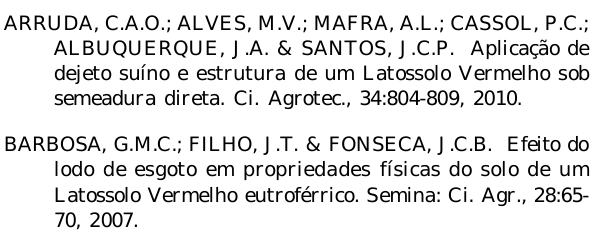
Areas studied: M7: maize, 7 years of organic fertilizer applications; M20: maize, 20 years of application; P3: annual pasture, 3 years of application; P15: annual pasture, 15 years of application; PP20: perennial pasture, 20 years of application; Mt20: yerba mate, 20 years of application; NF: native forest; P0: native pasture. Capital letters, in the rows, compare layers and small letters, in the columns, compare use systems, by the t test (p<0.05). LSD: least significant difference; CV: coefficient of variation.